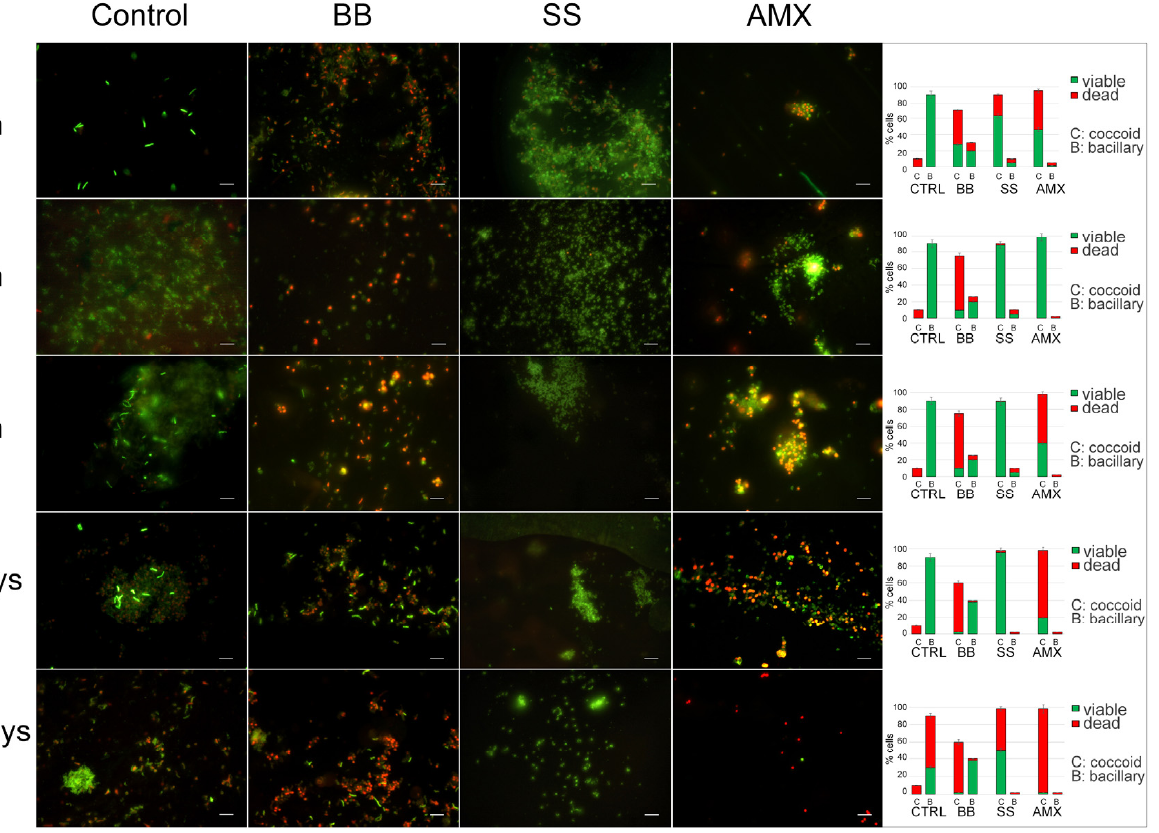
Figure 3. Induction of dormancy. Representative images of Live/Dead staining and the percentages of viable/dead spiral/coccoid morphotypes (graphics on the right) of H. pylori 10A/13 incubated in different conditions (BB, SS, and AMX) compared with the control, in time. The images observed by fluorescent Leica 4000 DM microscopy (Leica Microsystems, Milan, Italy) were recorded at an emission wavelength of 500 nm for SYTO 9 and of 635 nm for Propidium iodide, and several fields of view were randomly examined. Original magnification, 1000×.